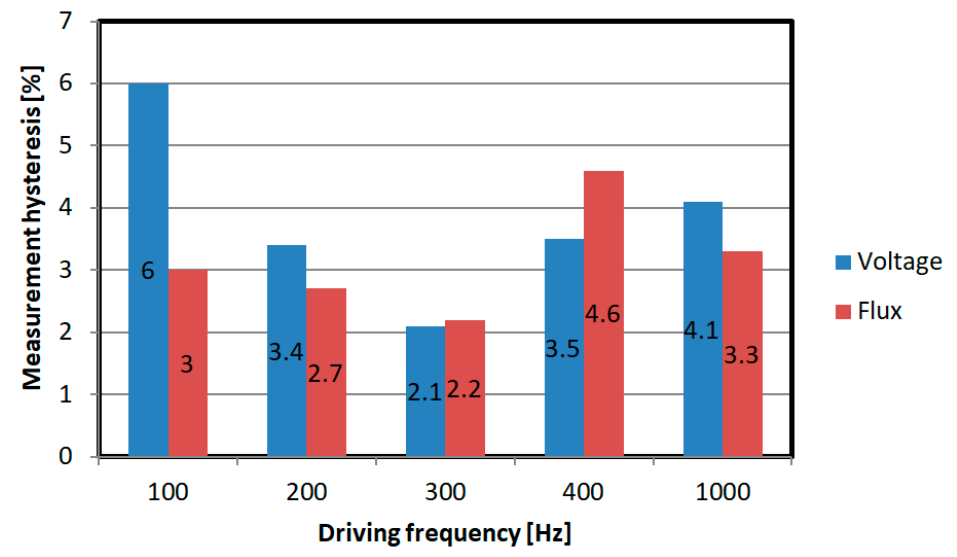
Figure 14. Comparison of maximum hysteresis errors depending on the frequency of the plate mag- netizing current. The frequency for which the smallest hysteresis error was obtained for the sinusoidal signal was 300 Hz, both for voltage and flux measurements. For this frequency, the hys- teresis error was re-examined for the triangular signal with the current at 1.75 A. The re- sults of these tests are presented in Figure 15.